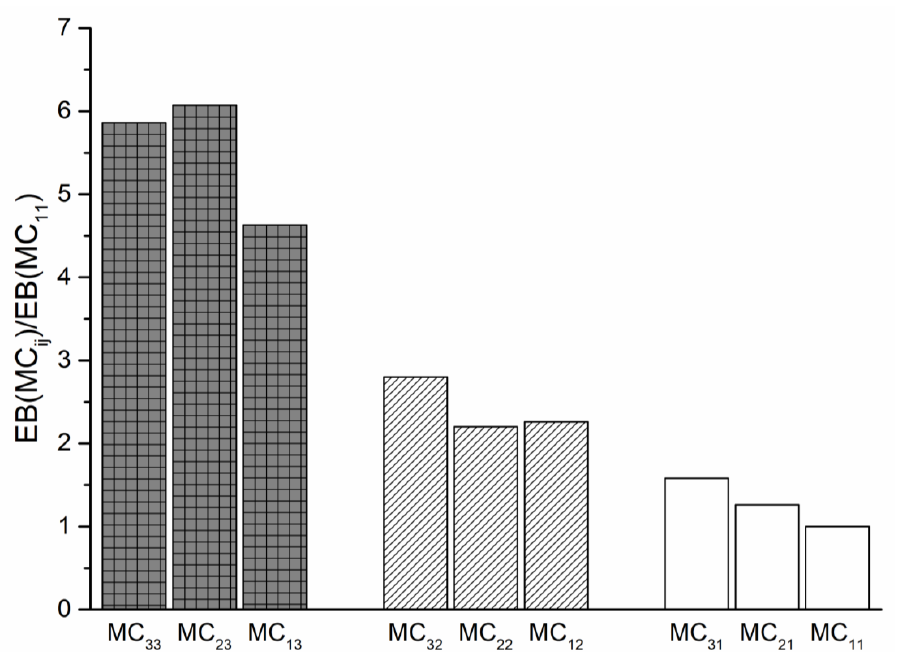
Figure 6. Histogram of the EB dimensionless values of all samples.